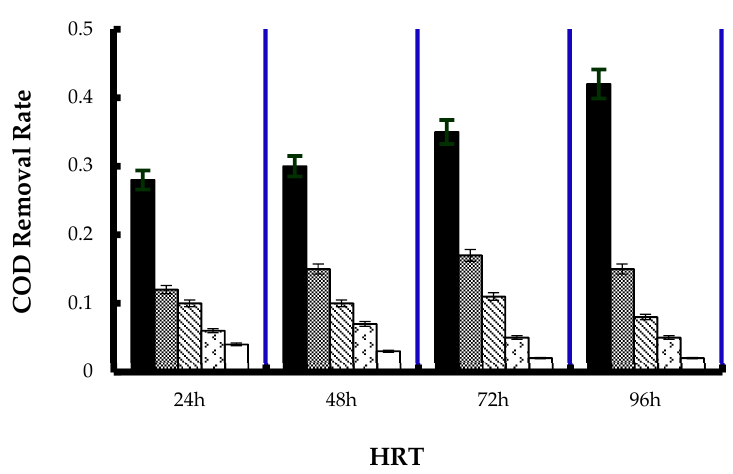
HRT Figure 3. COD removal efficiencies in different compartments of ABR under different HRTs. Figure 3. COD removal efficiencies in different compartments of ABR under different HRTs. Figure 3. COD removal efficiencies in different compartments of ABR under different HRTs. Figure 3. COD removal efficiencies in different compartments of ABR under different HRTs. Figure 3. COD removal efficiencies in different compartments of ABR under different HRTs. Figure 3. COD removal efficiencies in different compartments of ABR under different HRTs. Figure 3. COD removal efficiencies in different compartments of ABR under different HRTs. Compartment III; Compartment I; Compartment II; Compartment III; Compartment IV; Compartment I; Compartment II; Compartment III; Compartment IV; Compartment I; Compartment II; Compartment IV; Figure 3. COD removal efficiencies in different compartments of ABR under different HRTs. Compartment I; Compartment II; Compartment III; Compartment IV; Compartment I; Compartment II; Compartment III; Compartment IV; Compartment I; Compartment II; Compartment III; Compartment IV; Compartment V. Compartment V. Compartment V. Compartment V. Compartment I; Compartment II; Compartment III; Compartment IV; Compartment V. Compartment V. Compartment V. Compartment V.